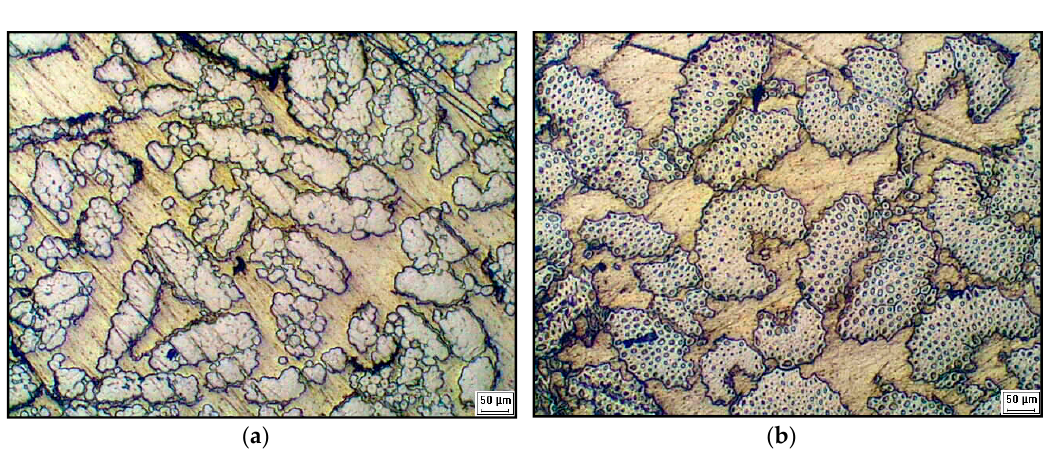
Figure 1. Optical micrographs of polished cross sections of natural fibre epoxy composites: ( a ) Flax fibre composites; ( b ) Sisal fibre composites.